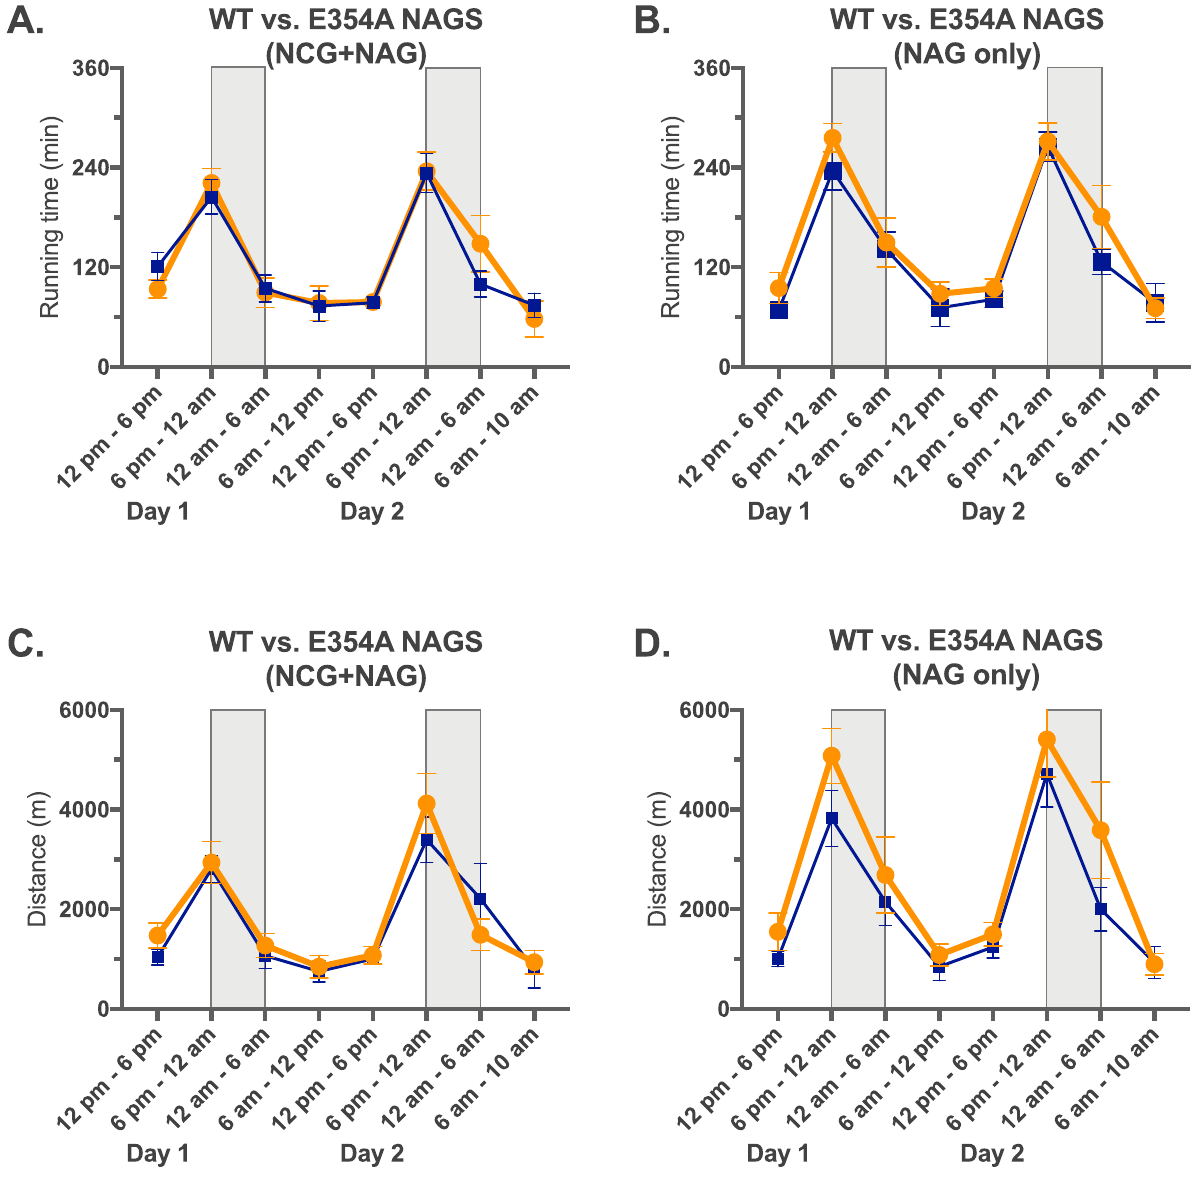
Figure 8. Behavior of Nags −/− mice that received the same dose of either AAV2/8NAGS.mNAGS-E354A or AAV2/8NAGS.mNAGS gene therapy. ( A ) Average running time during 6 h epochs before withdrawal of NCG supplementation. ( B ) Average running time during 6 h epochs after withdrawal of NCG supplementation. ( C ) Average running distance during 6 h epochs before withdrawal of NCG supplementation. ( D ) Average running distance during 6 h epochs after withdrawal of NCG supplementation. Orange—AAV2/8NAGS.mNAGS- E354A. Blue—AAV2/8NAGS.mNAGS. Shaded rectangles indicate nighttime when mice are more active. (NCG + NAG) indicates that both NCG and NAGS are present in the livers of experimental animals. (NAG only) indicates that NCG supplementation has been withdrawn and NAG is produced by the mNAGS expressed from the AAV-vector while NCG is absent from the livers of experimental animals. Shaded rectangles indicate periods of darkness between 6 PM and 6 E354A mutant mNAGS and the Nags −/− mice that expressed wild-type NAGS had different patterns of activity on the voluntary wheel. Hyperammonemic mice that received E354A mutant NAGS ran longer distances on the voluntary wheel during nighttime than the mice that received the same dose of wild type mNAGS. This was because hyperammonemic mice ran faster than the mice that received wild-type NAGS and both groups of mice spent similar amount of time running on the voluntary wheel. This suggests that hyperammonemic mice may be hyperactive, similar to patients with urea cycle disorders who can have symptoms of attention deficit hyperactivity disorder 41,42 .